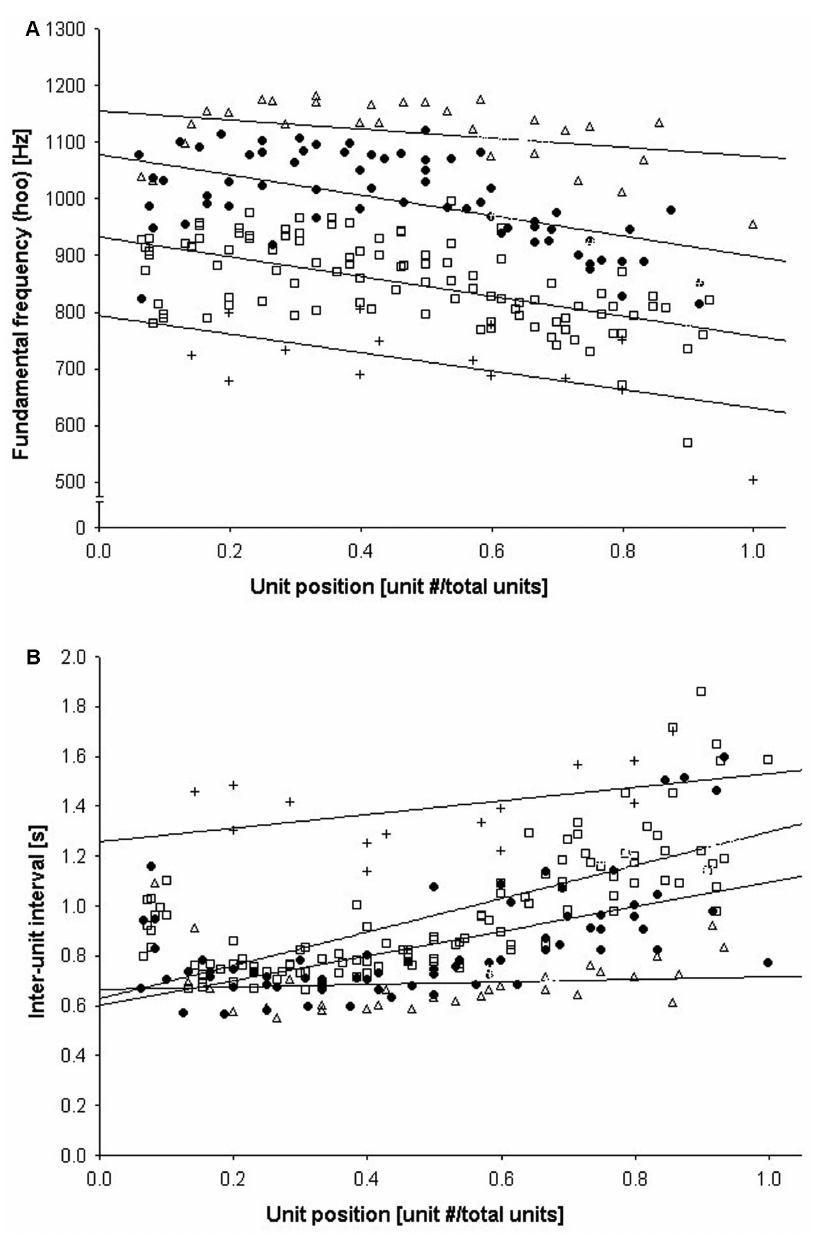
Figure 2. Changes in call characteristics as a function of unit position: (A) fundamental frequency of the hoo syllable and (B) inter- unit interval. Best-fit lines for individual males provided for demonstration purposes only. Table 1). On average, calls were 15.5 s in duration and consisted of 15.9 call units (range = 5–31), with an average inter-unit interval of 1.0 s (Table 1). Huh syllables showed significantly higher frequency characteristics than hoo syllables. Fundamental fre- quency averaged 1310.4 6 167.2 SD Hz in huh syllables, and Similarly, peak frequency of huh syllables averaged 3798.4 6 803.3 Hz, while hoo syllables averaged 3307.0 6 666.4 Hz ( t = 7.29, df =157, P , 0.01). We obtained sound pressure readings for 34 of these calls. Calls measured at 11–15 m ( N = 3) were 76.7 dB on average (range = 73.5–79.5), while those measured at 20–30 m ( N = 7) averaged 66.3 dB